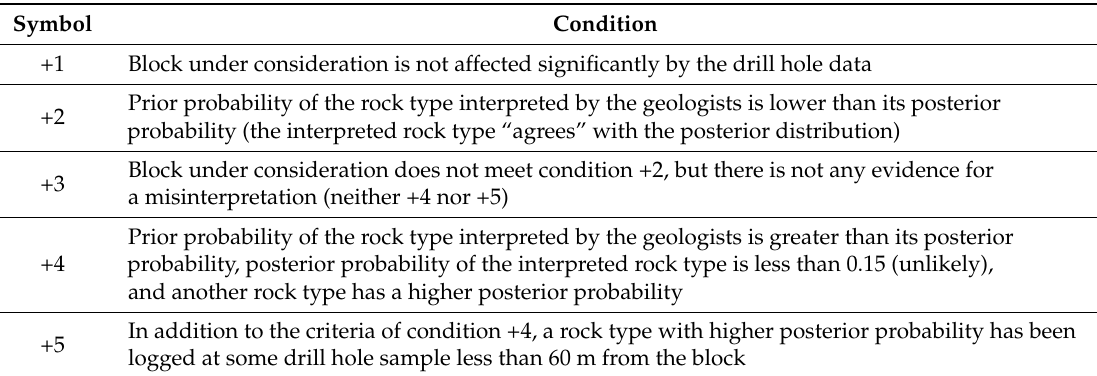
Figure 7. Isometric view of block classification according to criteria in Table 5, showing the plan view and vertical cross-sections passing through the origin (local coordinate system). Waste and air are shown in dark blue and grey, respectively. Table 5. Defined conditions.